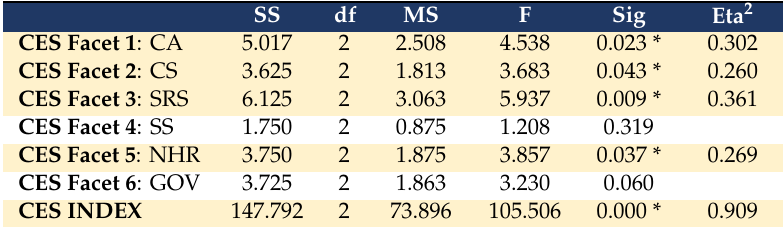
Table 2. One-Way ANOVAs. Table shows between-group di ff erences in community engagement across low, moderate, and high CES